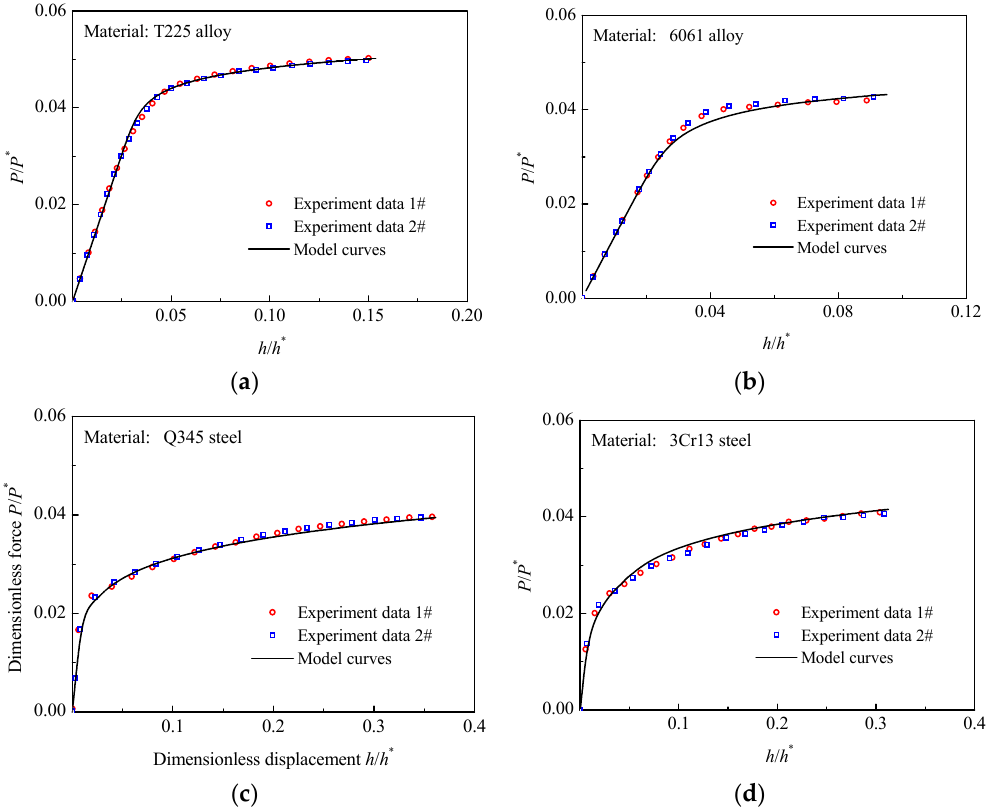
Figure 10. Experimental and Predicted P/P*~h/h* curves of the CHS specimens; ( a ) T225 titanium alloy; ( b ) 6061 aluminum alloy; ( c ) Q345 steel; ( d ) 3Cr13 steel.